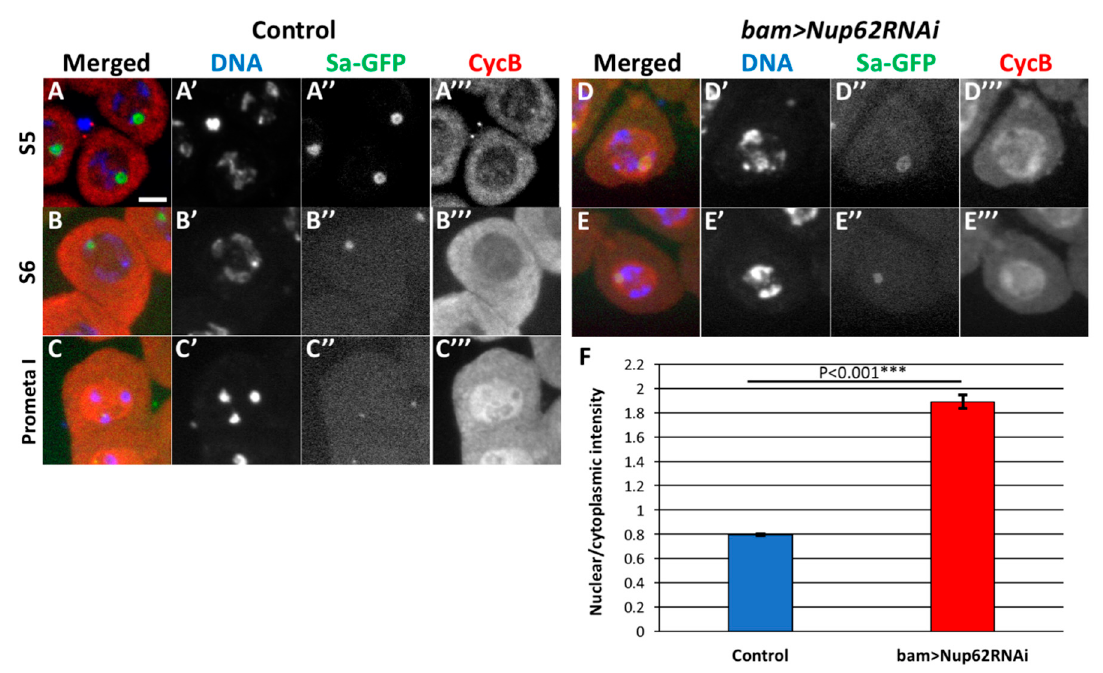
Figure 5. Depletion of Nup62 complex components compromised intracellular localization of